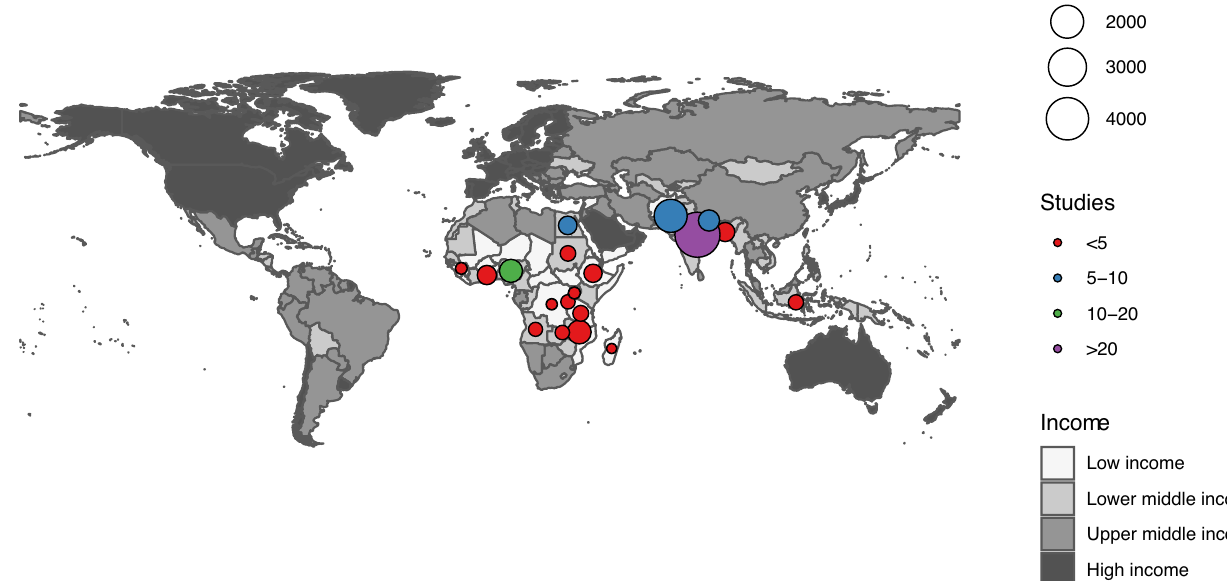
Fig 2. Distribution of included studies in low- and lower-middle-income countries. The world map was created using data from the public domain map dataset Natural Earth (https://www.naturalearthdata.com).